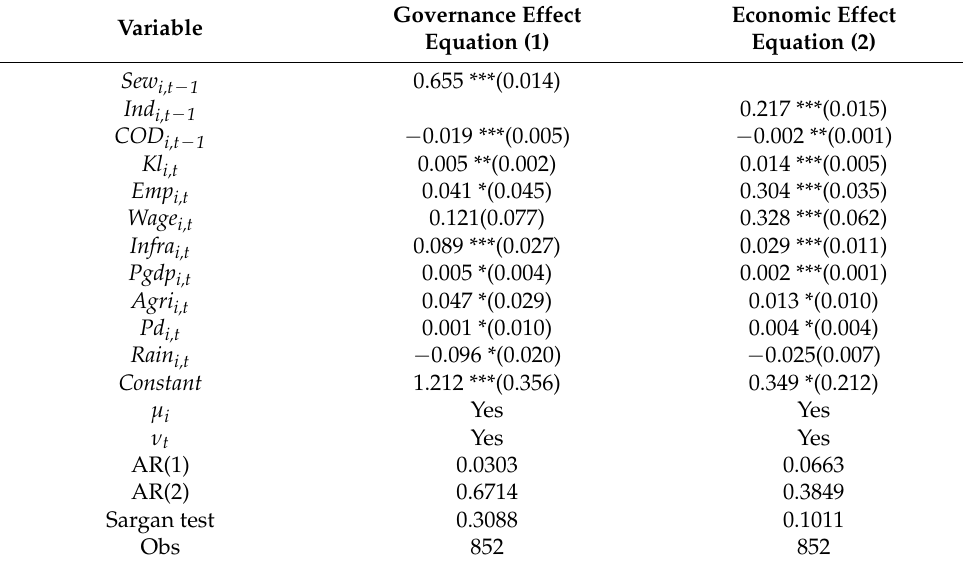
Table 2. Dynamic panel model estimation results of ambient water quality impact on water- polluting